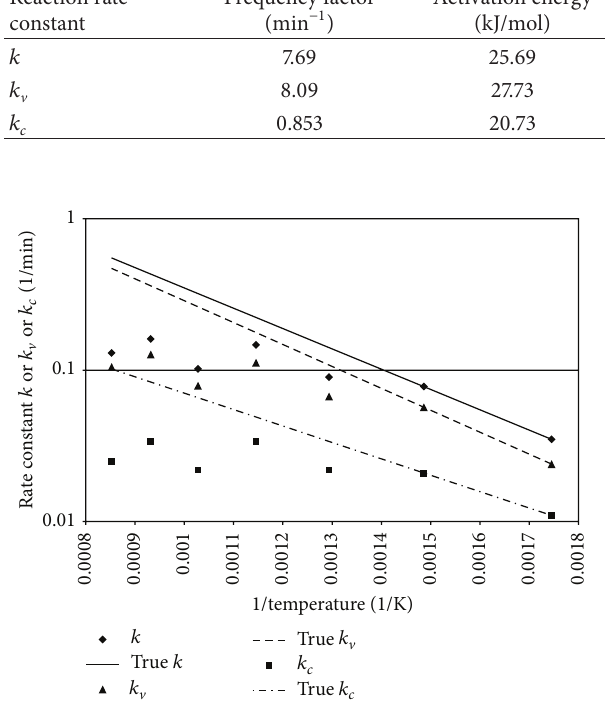
Figure 4: Simulated true 𝑘 , true 𝑘 V , true 𝑘 𝑐 , and experimental 𝑘 , 𝑘 𝑘 V , and 𝑐 values of rate constant for weight loss of newspaper, volatile formation, and char formation in logarithmic scale against reciprocal temperature.